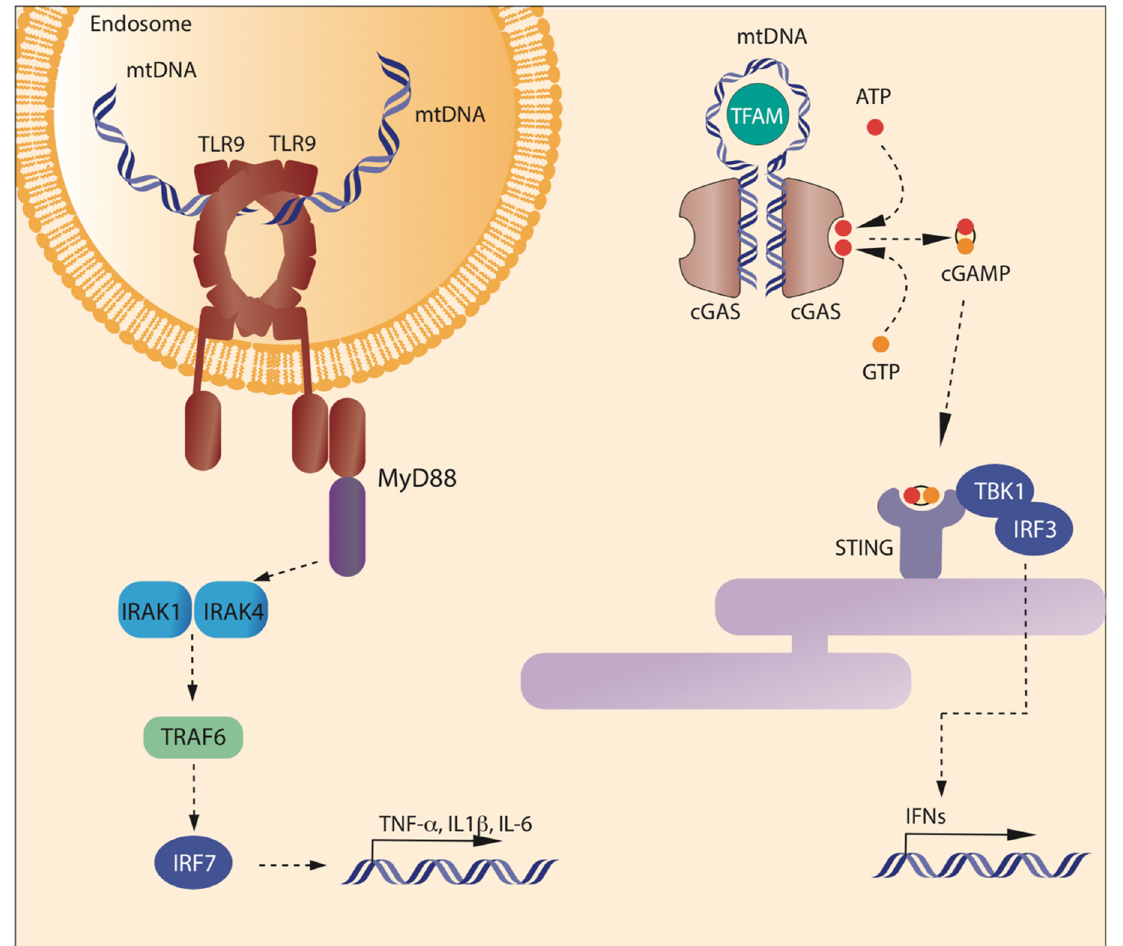
Figure 1. Binding of mtDNA to TLR9 and cGAS. Left: Toll-like receptor 9 (TLR9) is expressed in the inner face of the endosome membranes, as a homodimeric complex. TLR9 is activated by unmethylated CpG sequences present in DNA molecules, including mtDNA, through a sequence specific binding to the N-term of the C-shaped leucine-rich repeat region of TLR9. Each monomer binds different DNA molecules. Once bound to DNA, the cytosolic domain of TLR9 promotes the activation of MyD88 pathway, which ultimately leads to the transcription of inflammatory cytokines. In the cytosol, mtDNA can be bound by cyclic GMP-AMP Synthase (cGAS) that forms form cyclic GMP-AMP (cGAMP) from GTP and ATP. cGAMP binds to Stimulator of Interferon Genes (STING) on the endoplasmic reticulum. STING promotes the phosphorylation of IRF3 mediated by TBK1, which leads to the transcription of inflammatory genes.